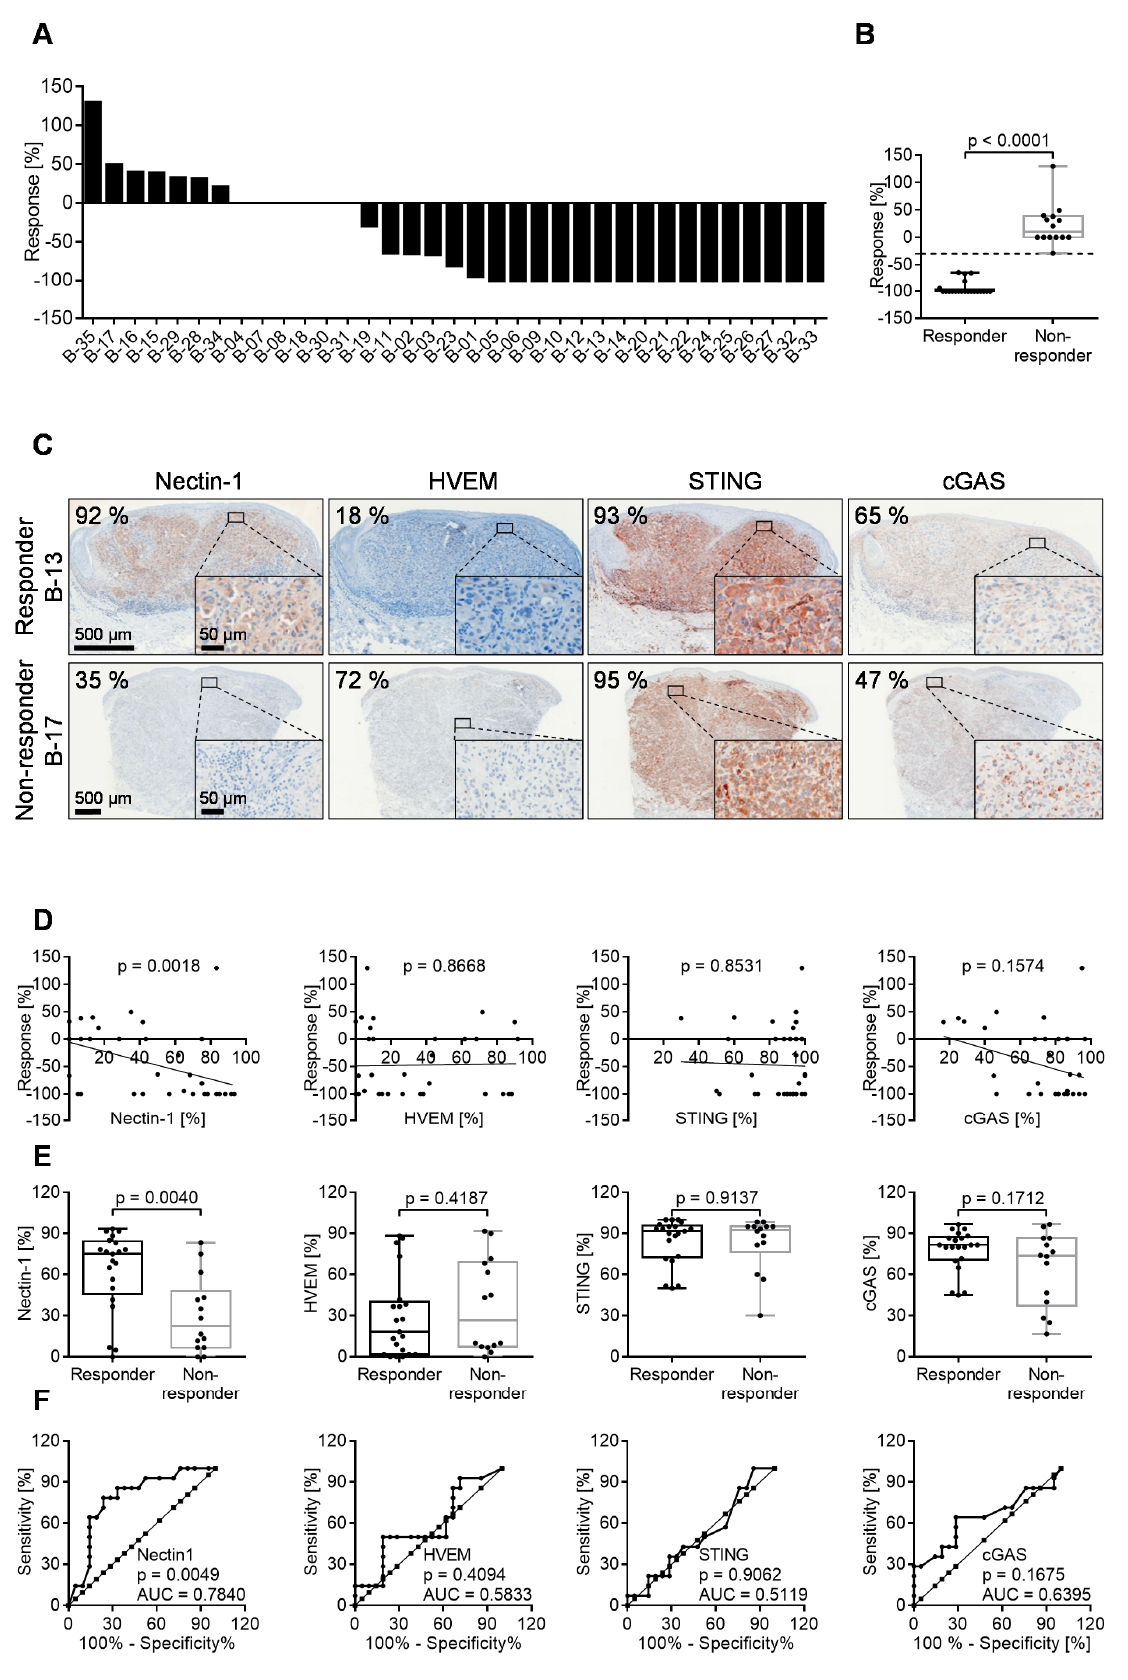
Figure 5. Oncolytic effect of T-VEC upon injection into 35 malignant melanoma lesions. ( A ) Waterfall plot showing